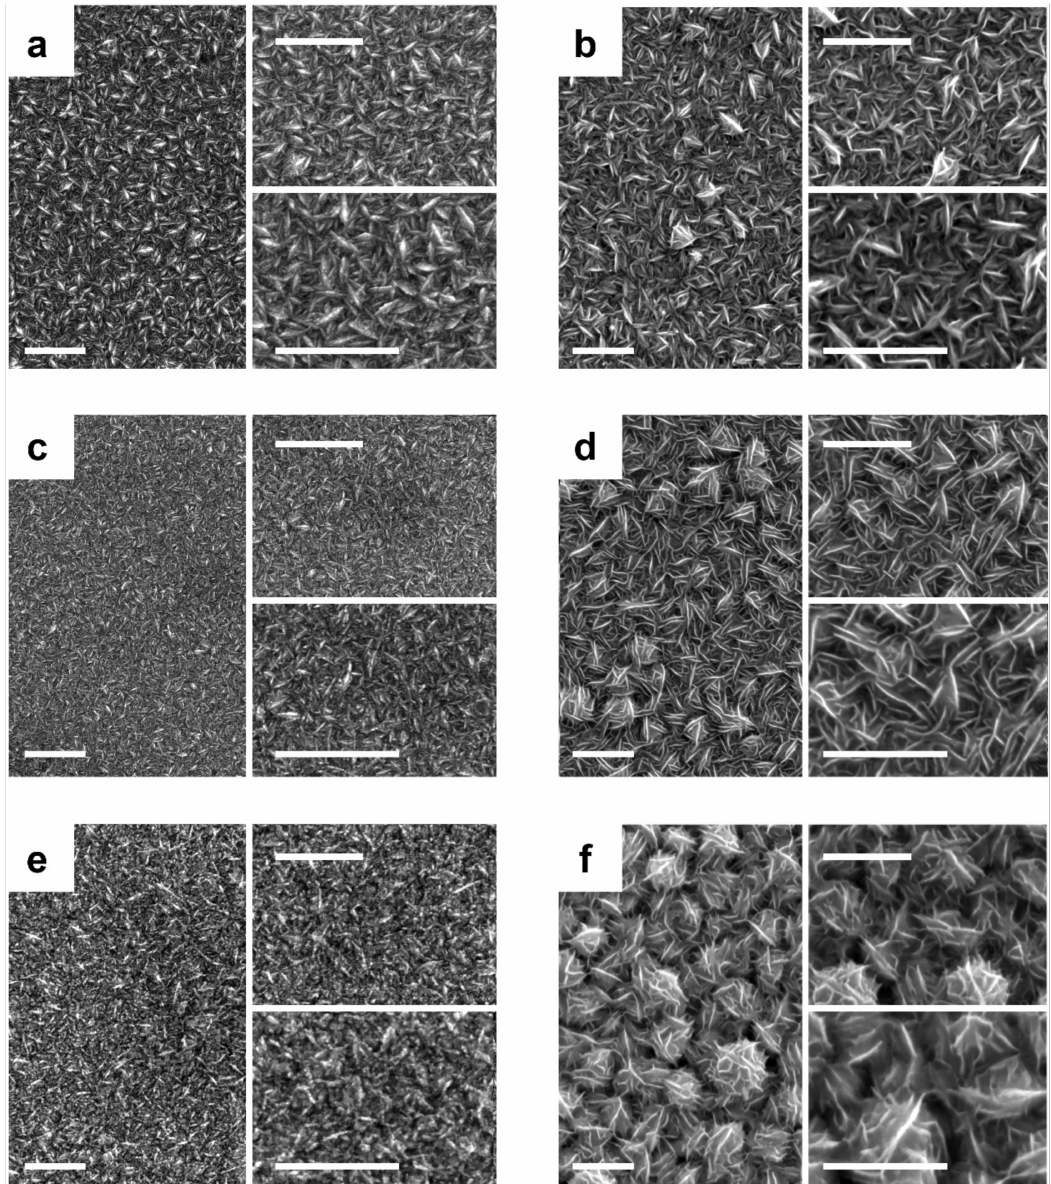
Figure 1. FE-SEM micrographs of ( a , c , e ) Ni-rich CoNi and ( b , d , f ) Co-rich CoNi deposits ( a , b )